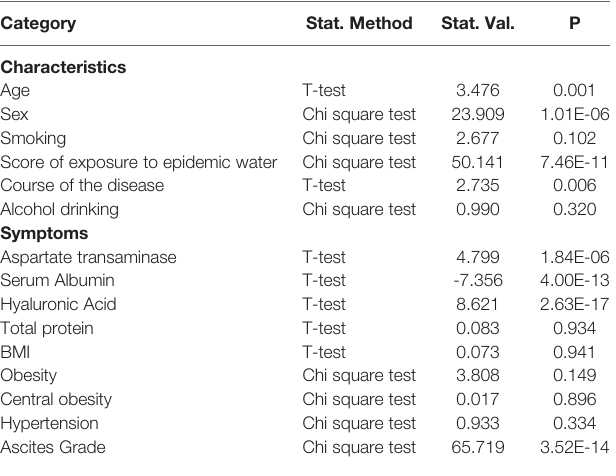
TABLE 1 | Statistical test to compare the statistical discrepancy of clinical characteristics between schistosomiasis patients at different stages.